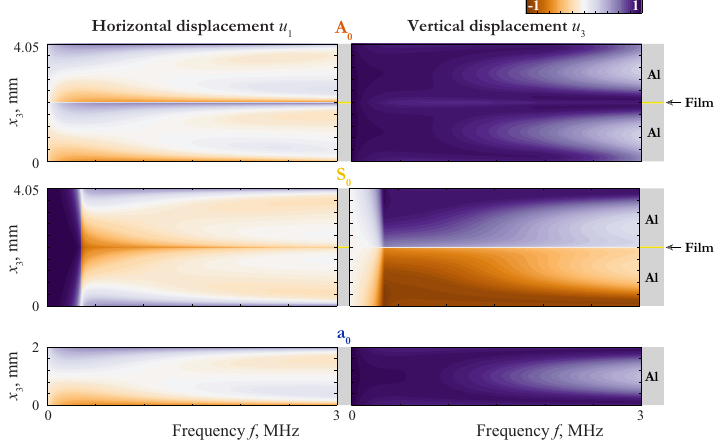
Figure 3. Displacement distribution u k ( x 3 , f ) of LWs A 0 and S 0 propagating in 4.05 mm thickness plate (2 mm aluminium/50 µ m film/2 mm aluminium) and LW a 0 propagating in 2 mm thickness aluminium